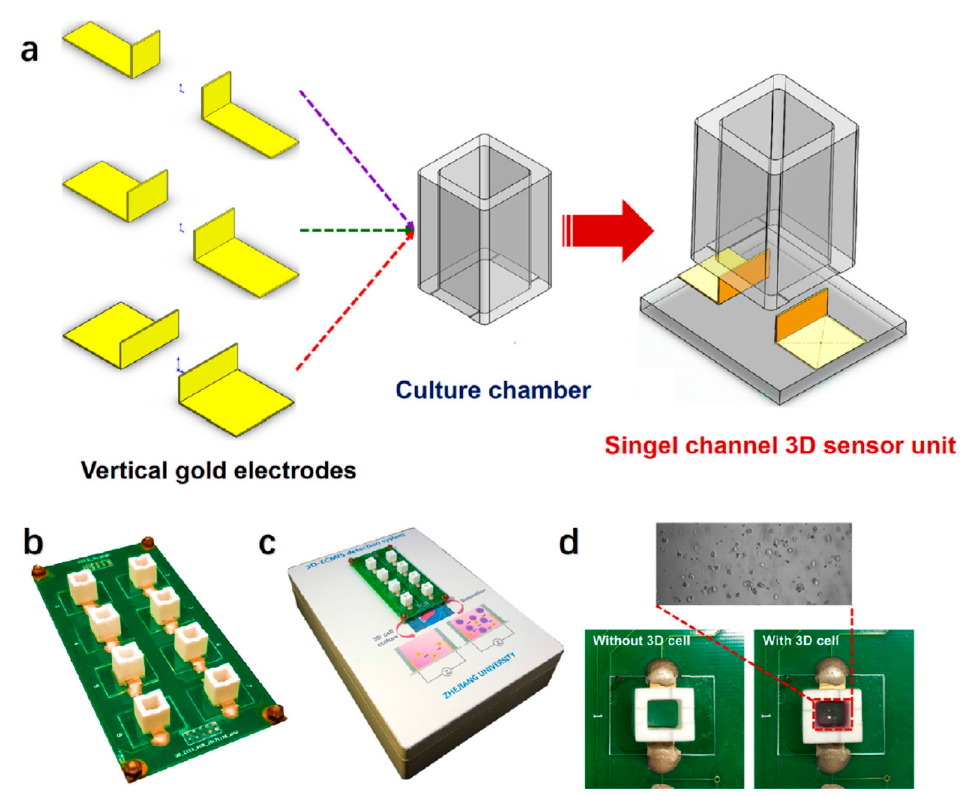
Figure 7. Schematic of the different parts of 3D electric cell/matrigel-substrate impedance sensing (3D-ECMIS): ( a ) vertical gold electrodes in a single channel, ( b ) arrangement of 8 channels on the scaffold, ( c ) picture of the eight channels in the detection system, and ( d ) images of the 3D cell-based biosensor before and after seeding the living cells. Reprinted from Pan et al. [76] with permission from Elsevier.